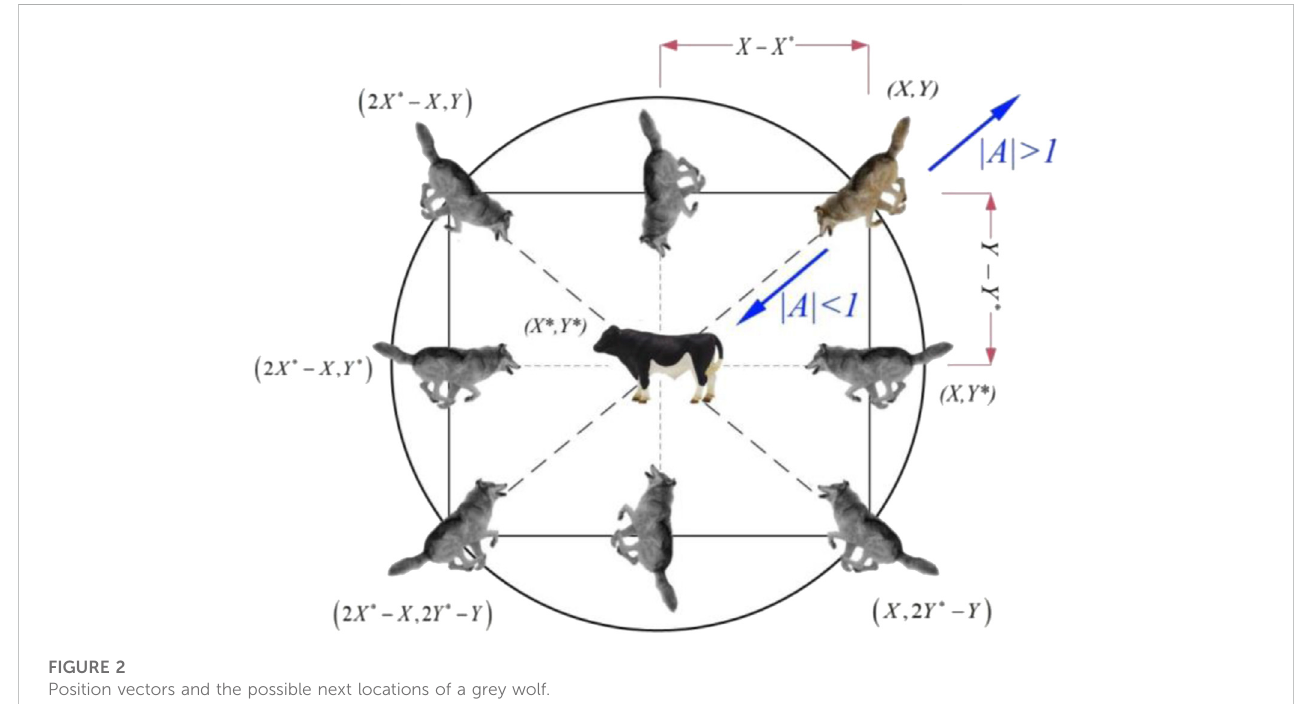
FIGURE 2 Position vectors and the possible next locations of a grey